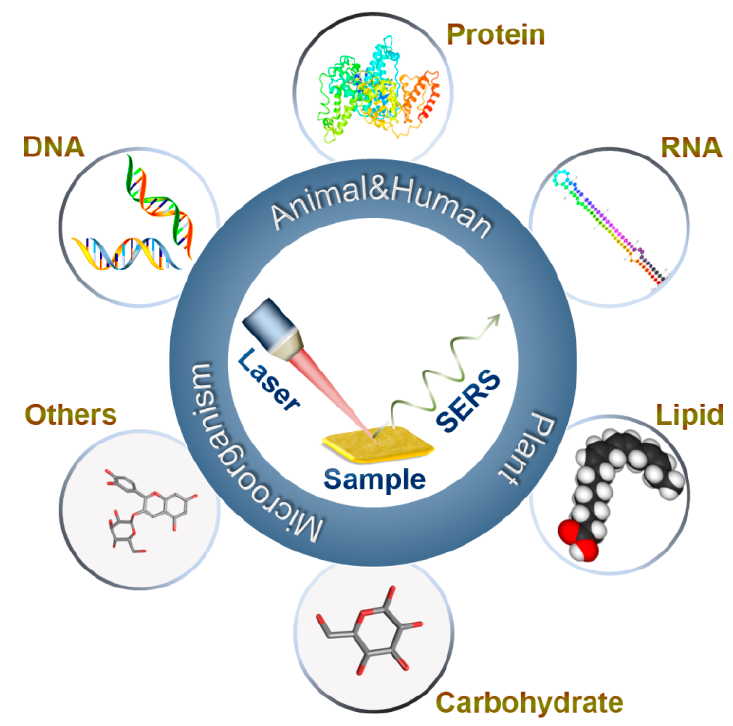
Figure 1. SERS detection of biomolecules.